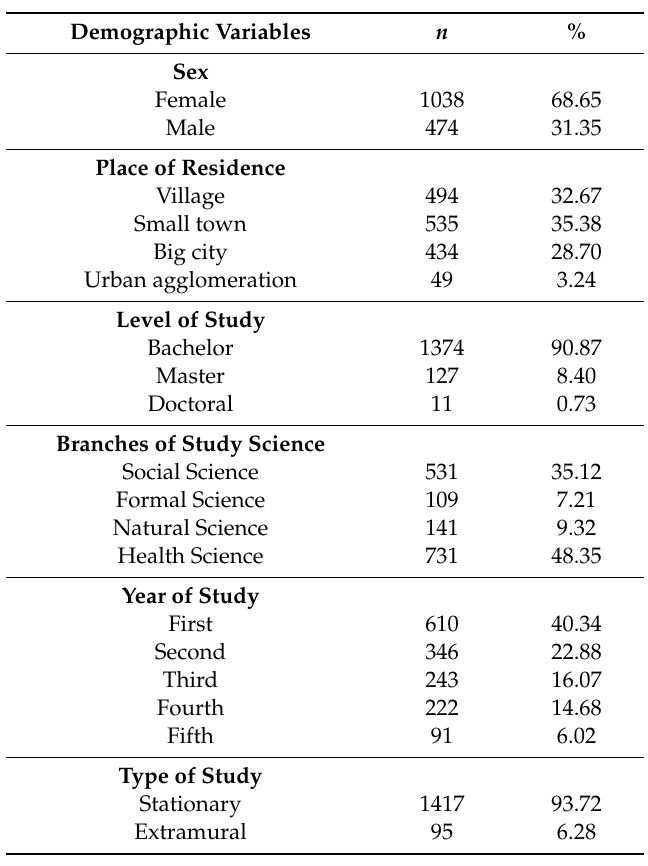
Table 1. Demographic characteristics of the study